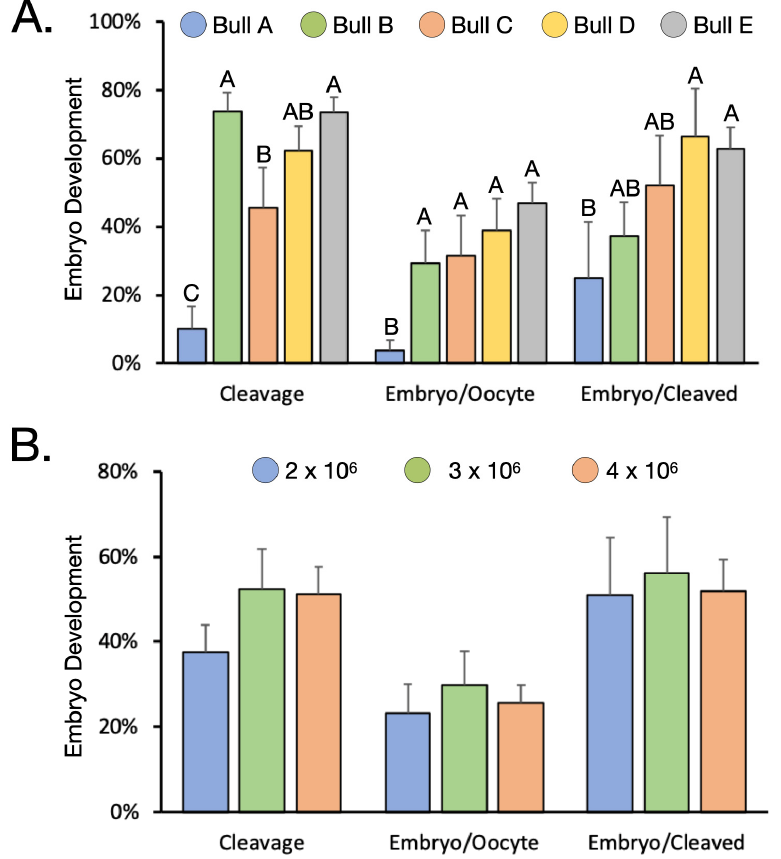
Figure 4. The effect of sire and semen concentration. ( A ). Embryo development according to bull used for IVF. ( B ). The effect of semen concentration for bull D. Values within the same chart with different script (A–C) differ significantly ( p < 0.05).